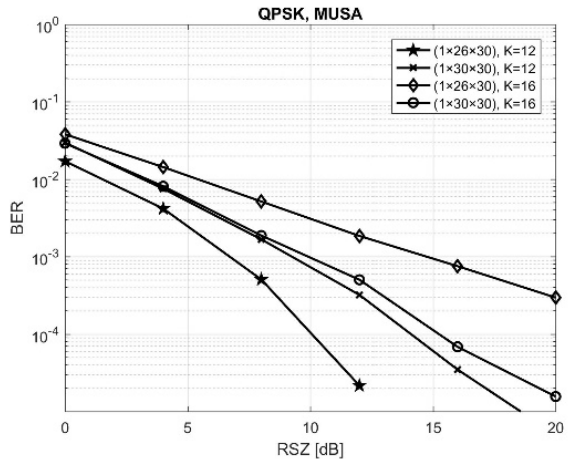
Figure 6. BER vs. SNR for a (1 × 26 × 30) and (1 × 30 × 30) MIMO configurations, QPSK modulation, MUSA with 12, 16 active users.